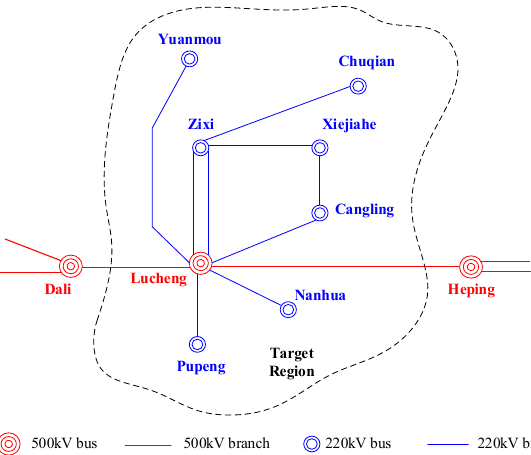
Figure 7. Single-line diagram of the Chuxiong region power grid.